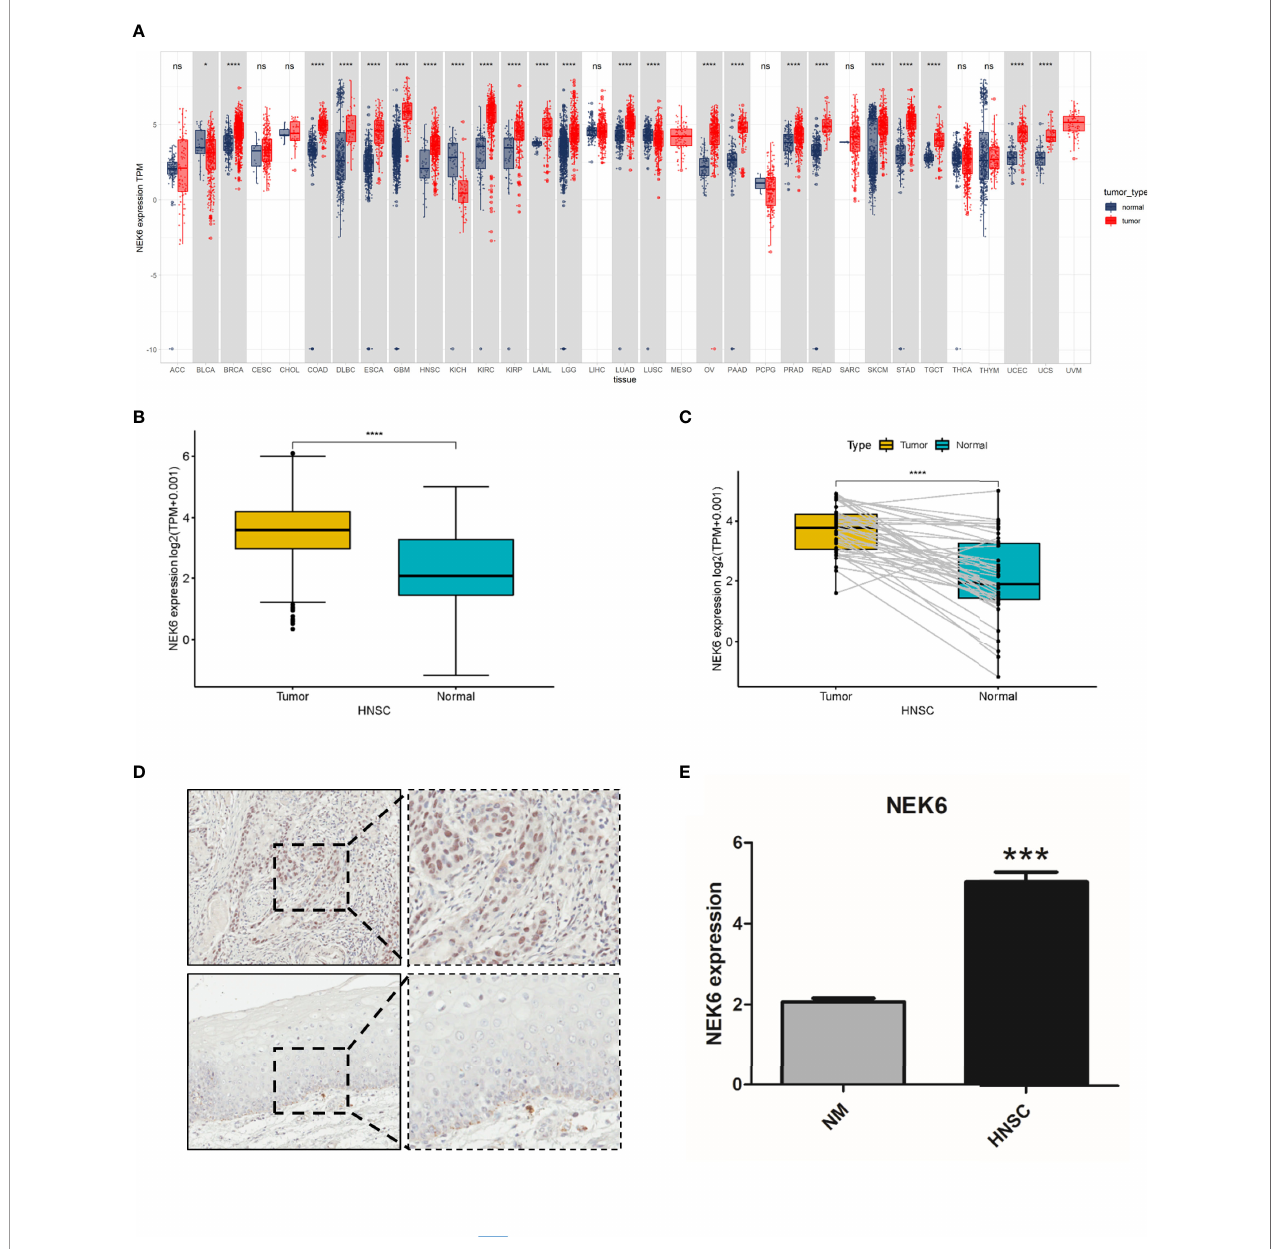
FIGURE 1 | Expression of NEK6 in HNSCC. (A) NEK6 expression in different types of cancer was investigated with the TIMER database. (B) Analysis of NEK6 expression in HNSCC and adjacent normal tissues in the TCGA database. (C) TCGA database and statistical analyses of HNSCC expression in HNSCC tissues and paired adjacent normal tissues. (C) Immunohistochemical staining of NEK6 was performed in HNSCC and normal mucosa. Representative images are shown. Scare bars, 50 mM. (D, E) The staining was quanti fi ed, as shown. ***p <